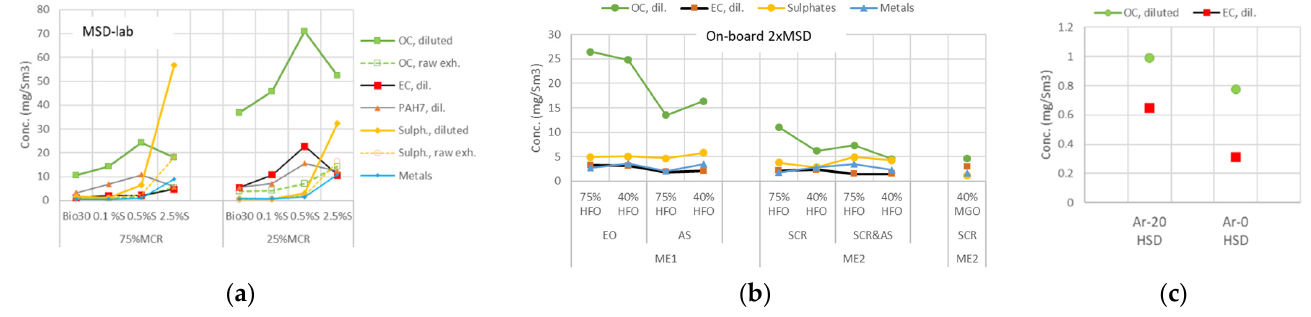
Figure A1. Measured OC, EC, sulphate, PAH, and metal concentrations for ( a ) MSD engine in laboratory (diluted and raw exhaust), ( b ) MSD engines in on-board campaign (EO = engine-out exhaust, AS = after scrubber; on-board 2 × MSD), and ( c ) HSD engine in laboratory (Fuels Ar-20, Ar = 0. HSD).